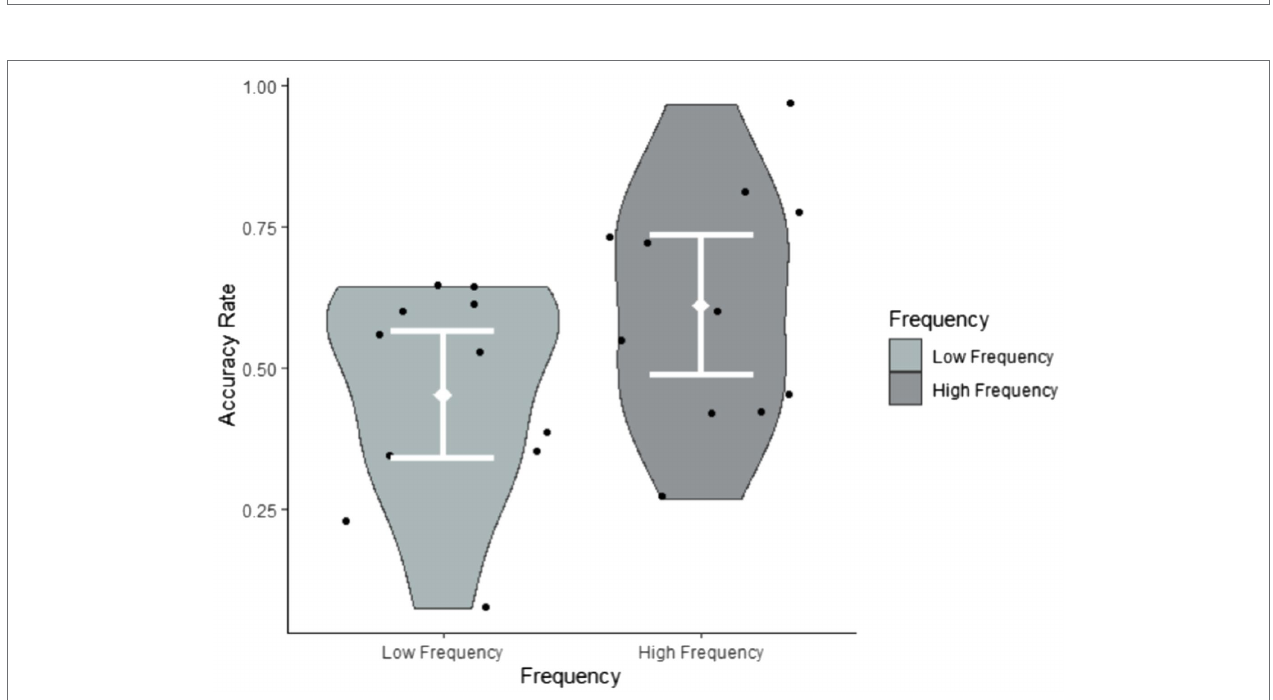
FIGURE 4 | Accuracy rates by frequency summarised by participants.